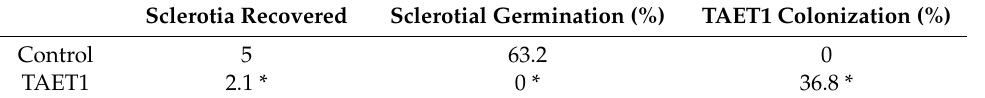
Table 4. Effects of applying T. aggressivum f. europaeum TAET1 on sclerotia of S. sclerotiorum. Number of sclerotia recovered, percentage of sclerotial germination, and TAET1 colonisation measured after 25 d of incubation. * Values represent means of five replicates. Data were analysed using Student’s t -test ( p < 0.05).